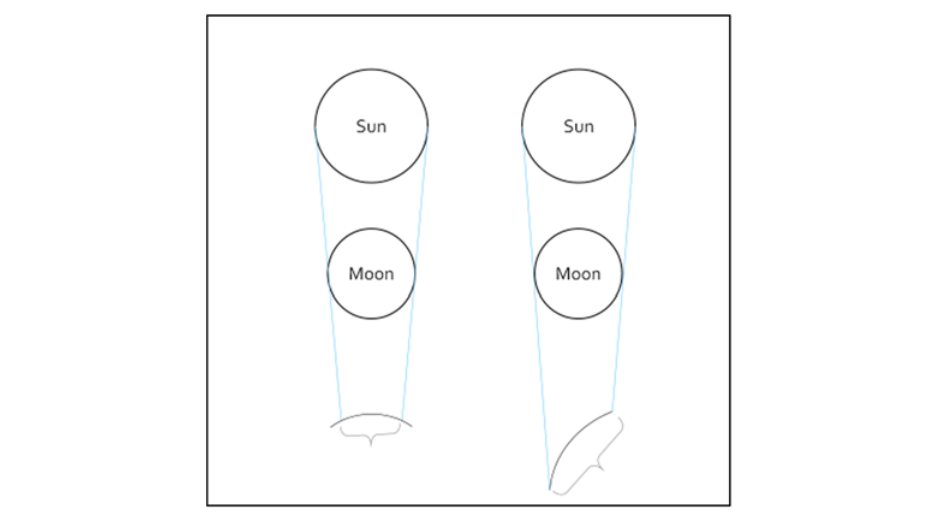
Fig. 3. The path of totality is wider towards the edges of the